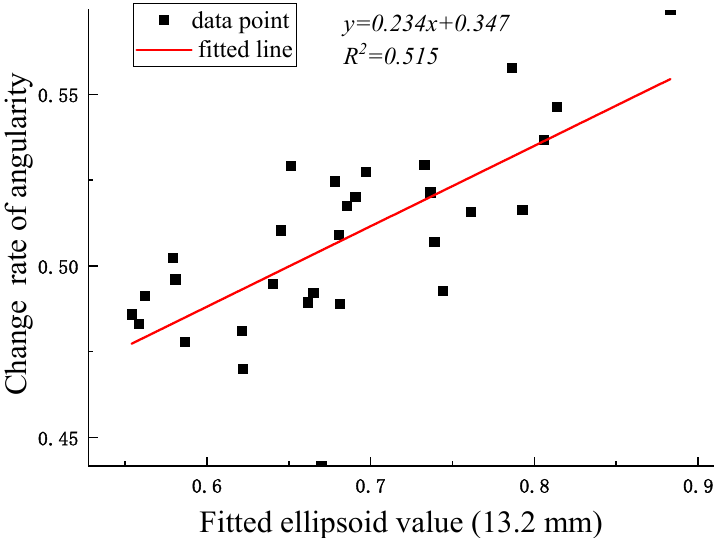
Figure 18. Correlation between fi tt ed ellipsoid value and change in angularity (13.2 mm).